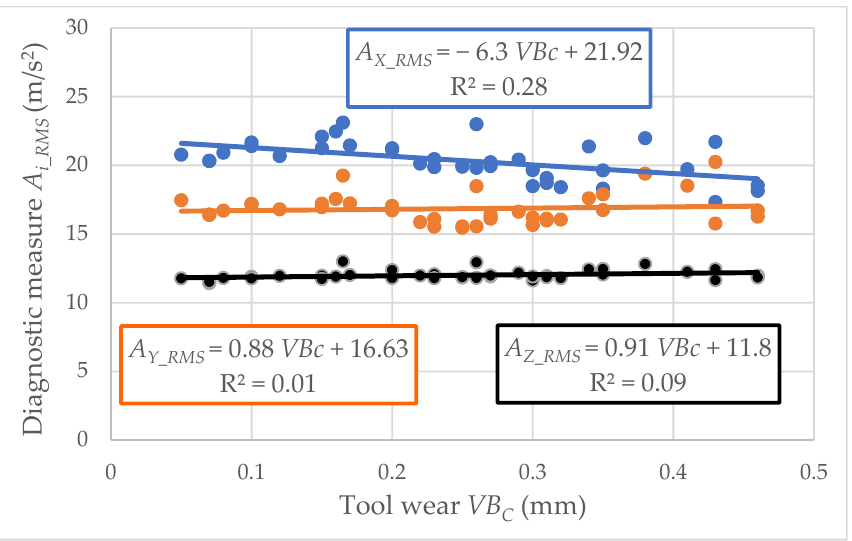
Figure 8. Relation between the vibration acceleration amplitude and tool wear VB C (cutting speed v c = 433 m/min; edge 2).